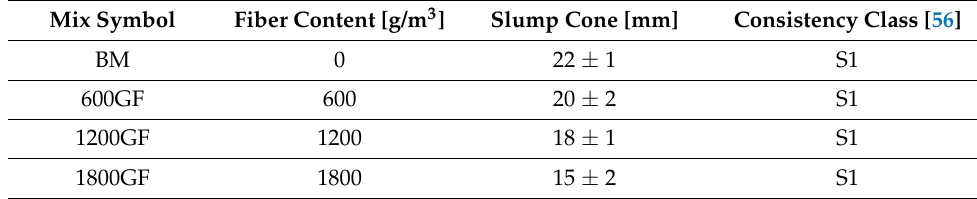
Table 5. The slump cone test